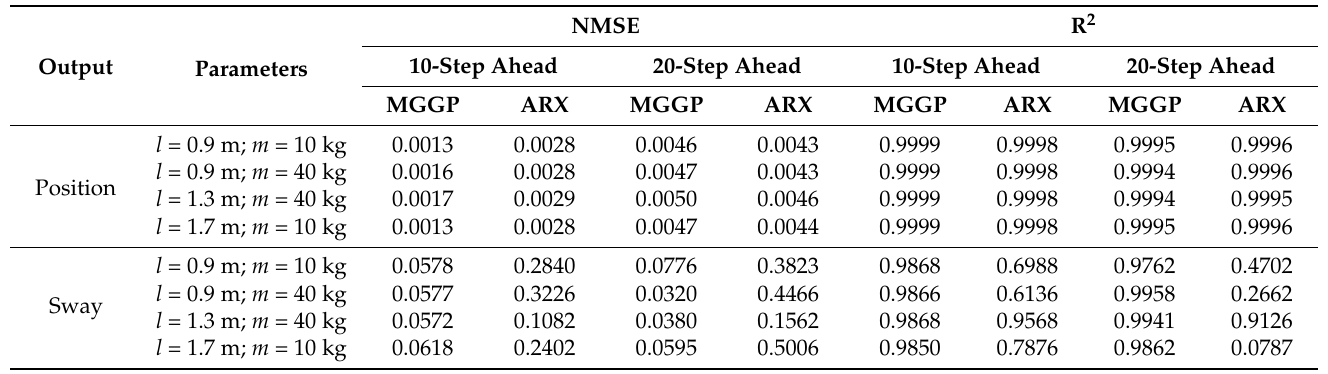
Table 5. Statistics of the identified prediction model of the simulated system.